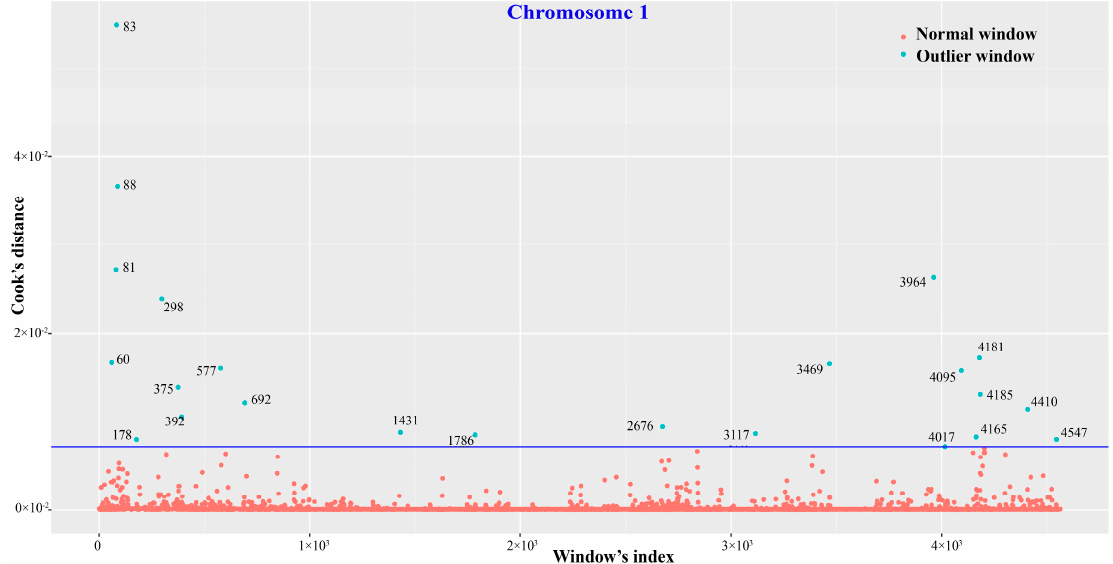
Figure 3. Outlier test of nonsynonymous SNV distribution patterns on chromosome 1 for eight macaque individuals using Cook’s distance test in R. The blue circles represent outlier chromosomal bins that hold significantly more nsSNVs than others. In addition, the numbers next to the blue circles are Cook’s distances of the outlier bins. The dark blue line shows the threshold we used that is 30 times of the mean Cook’s distance.